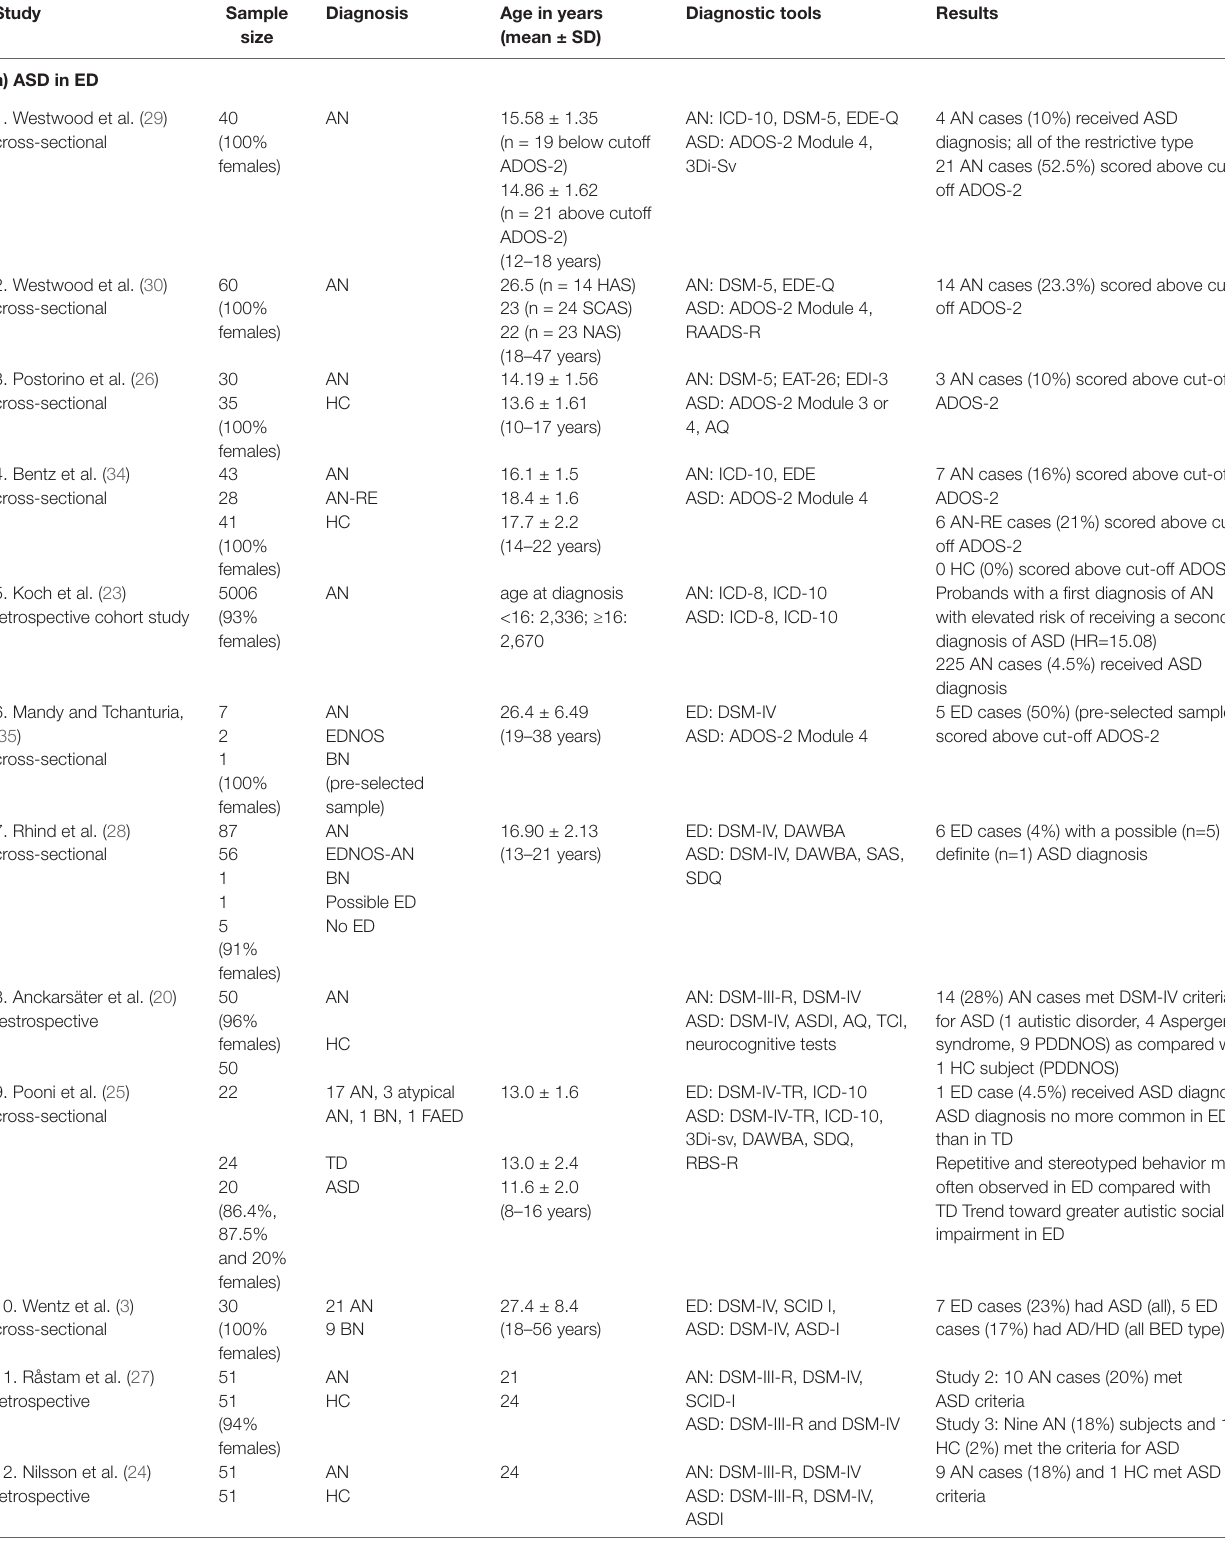
TABLE 2 | Previous prevalence studies in patients with EDs (AN, BN, BED) and